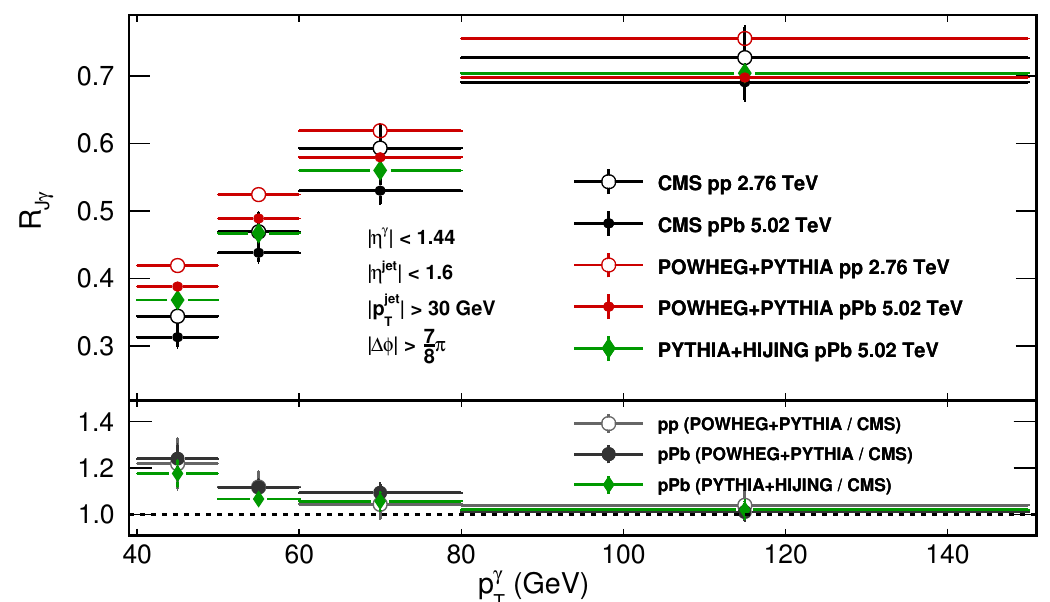
Figure 7 . Fraction of photons associated to a jet with p jet > 30 GeV as a function of photon T transverse momentum in pp (open circles) and pPb (full circles) collisions at the LHC with a p centre-of-mass energy per nucleon of s NN = 2 : 76 and 5.02 TeV, respectively. CMS 2013 data (black) are compared to predictions in LO with PYTHIA+HIJING (green) and NLO+PS with POWHEG+PYTHIA (red). The lower panel shows the ratio of theory over data for pp (open circles) and pPb (full circles and green